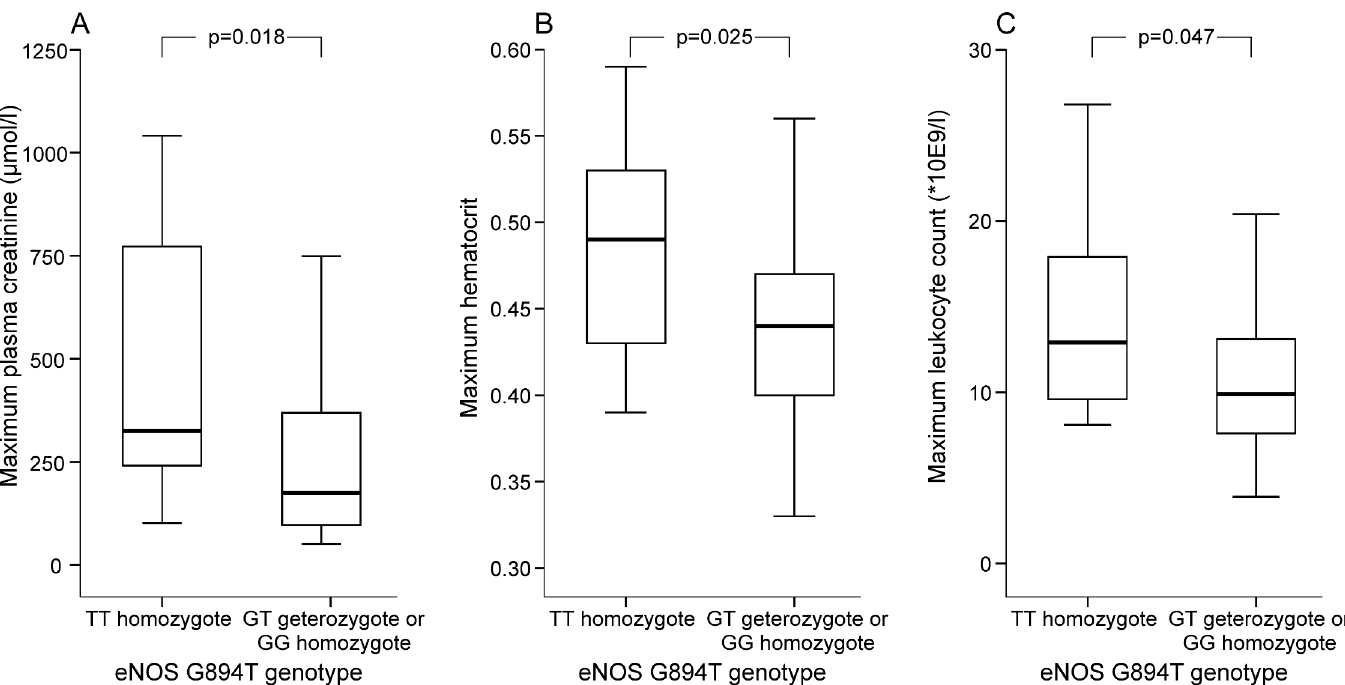
Fig 1. Box plots of the maximum plasma creatinine (A), hematocrit (B) and leukocyte count in TT-homozygotes (n = 10) and GT-heterozygotes or GG-homozygotes (n = 157) of eNOS G894T(rs1799983) polymorphism in 169 patients with PUUV infection. Box plot illustrates median (thick line inside box), 25 th and 75 th percentiles (box), and range (whiskers). Extremes and outliers have been omitted from the